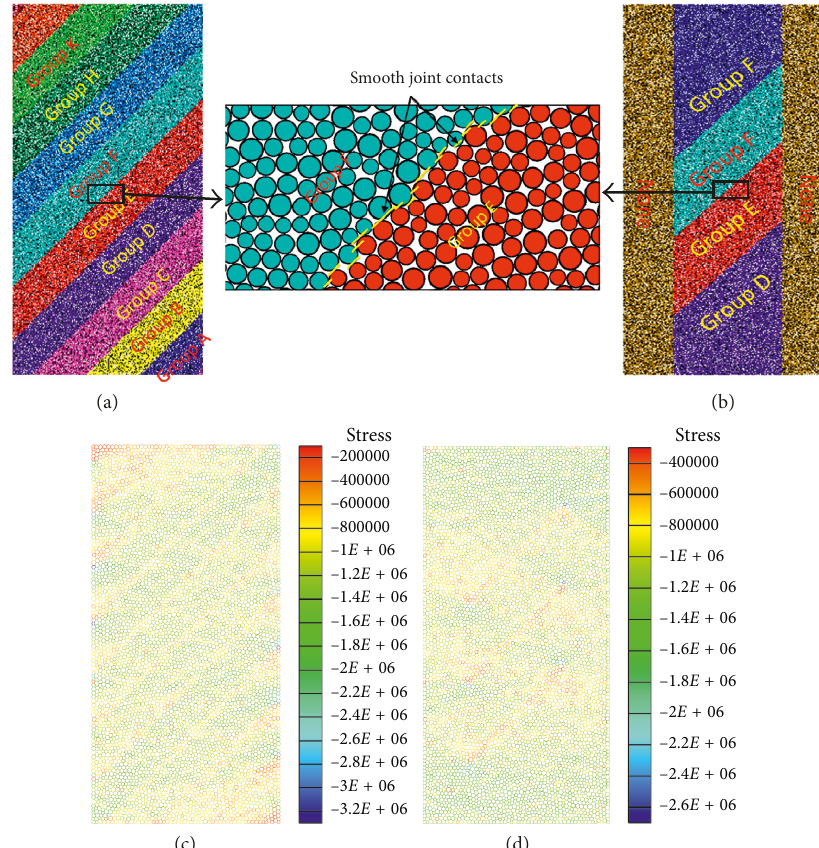
Figure 11: Generation of specimens with multiple groups of joints. (a) Persistent joints; (b) nonpersistent joints; (c) initial stress dis- tribution for the persistent joints; (d) initial stress distribution for the nonpersistent